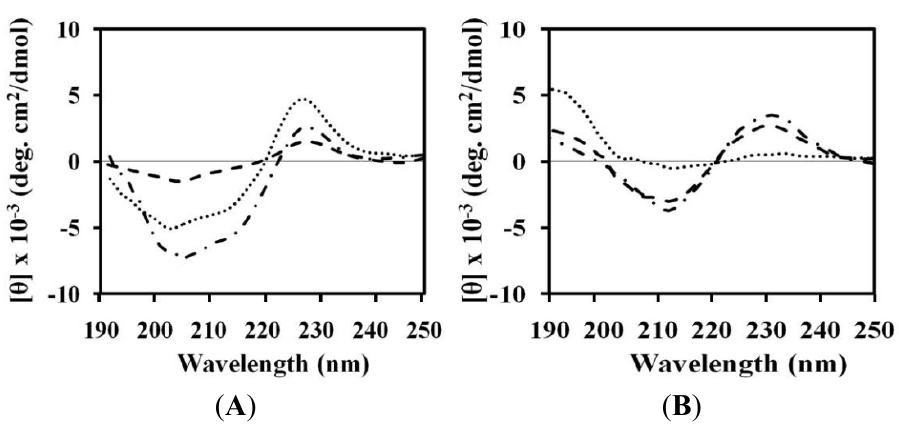
and (KW) peptides in the presence of PC (dashed 4 5